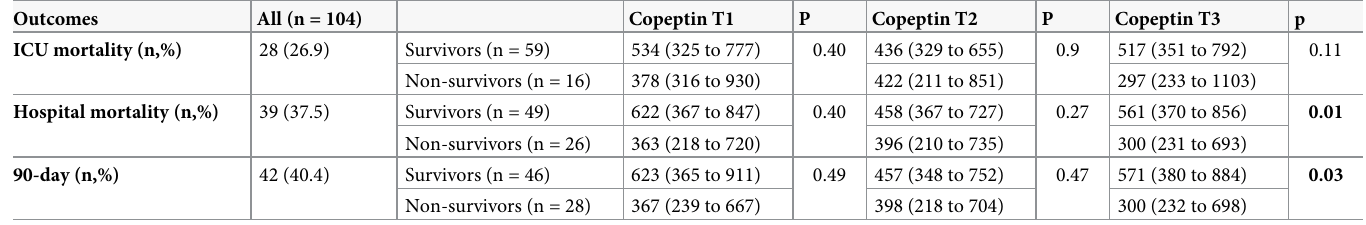
Table 3. Copeptin levels and mortality.